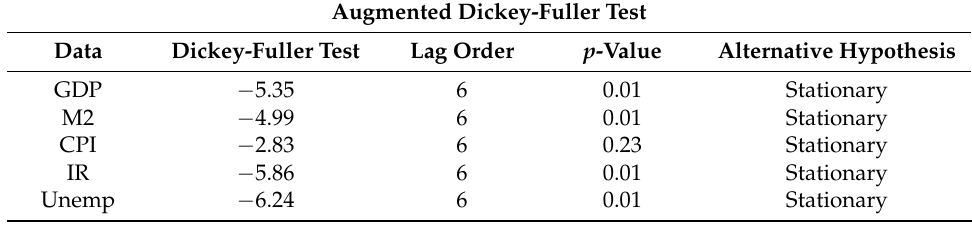
Table 3. Augmented Dickey-Fuller test after stabilize the mean of data through applying the dif- ferencing technique.